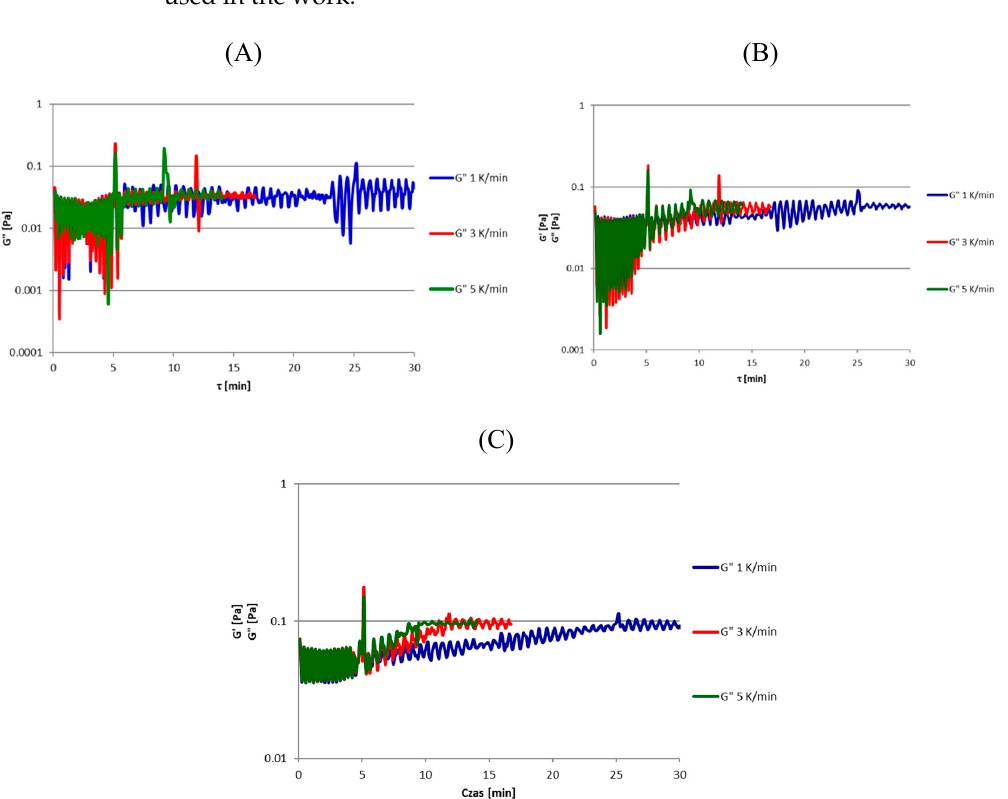
Figure 3. Gelatinization curves of a soy protein isolate solution with different concentrations and cooling rates. Soy protein isolate concentration: (A) - 4%, (B) - 8% and (C)- 12%.